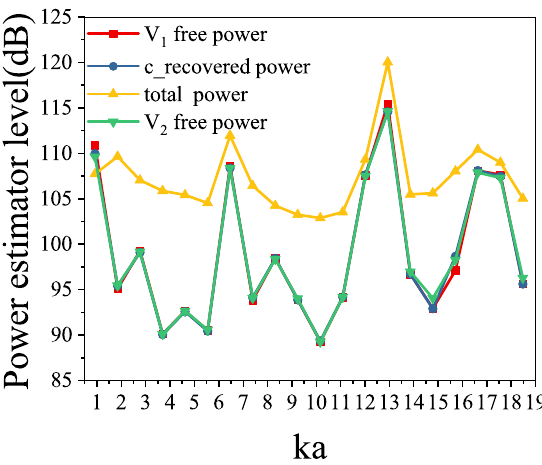
Figure 4. Sound power level on the measurement surface.